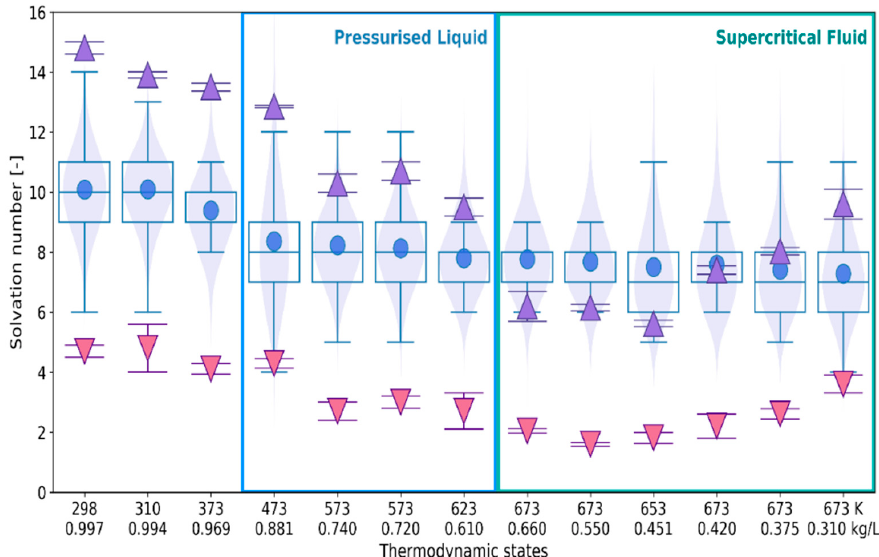
Figure 9. The number of faces N F (circles in box-and-whiskers-violin plot) versus RDF-based assessment of solvation number of the • OH aq : by integration of the O r –O w RDF to the 1st maximum (down triangles), to the 1st minimum (up triangles). The thermodynamic states are defined by tem- perature and density as in Table 1. The violin plots additionally show the values of the probability density distribution